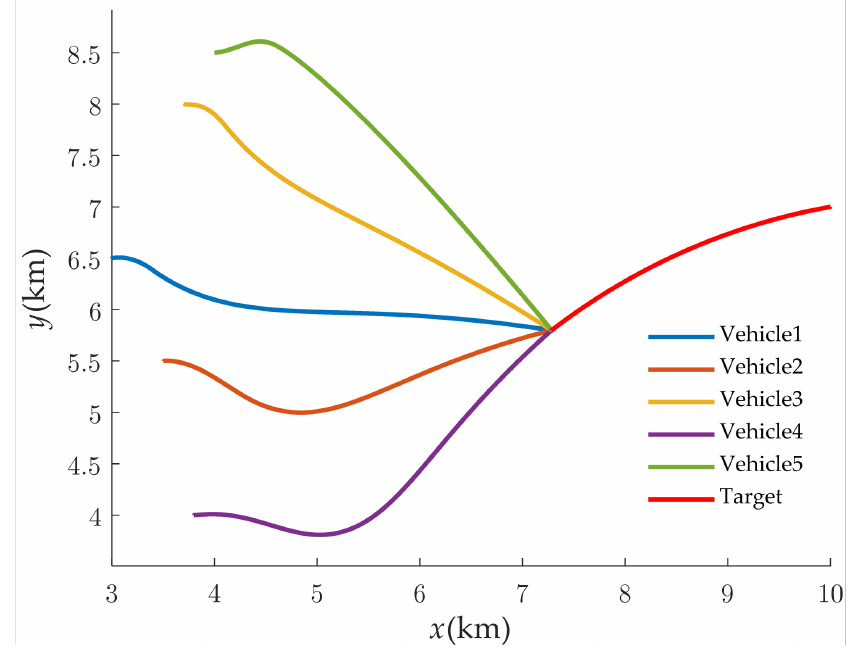
Figure 4. Trajectories of the vehicles and